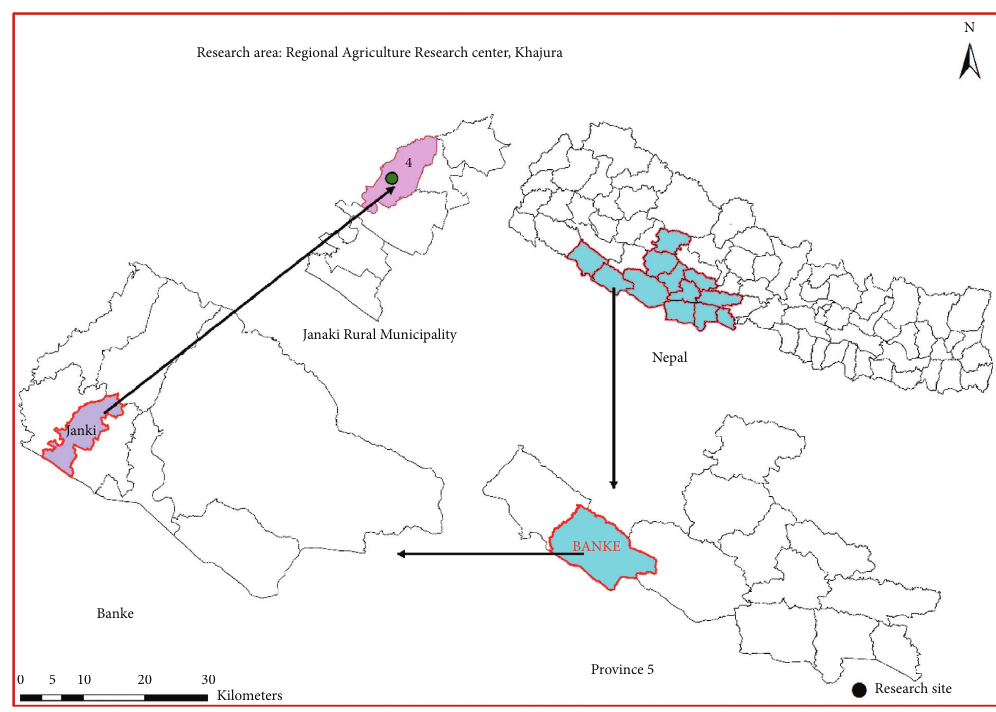
Figure 1: Location of experimental site at Regional Agriculture Research Station,